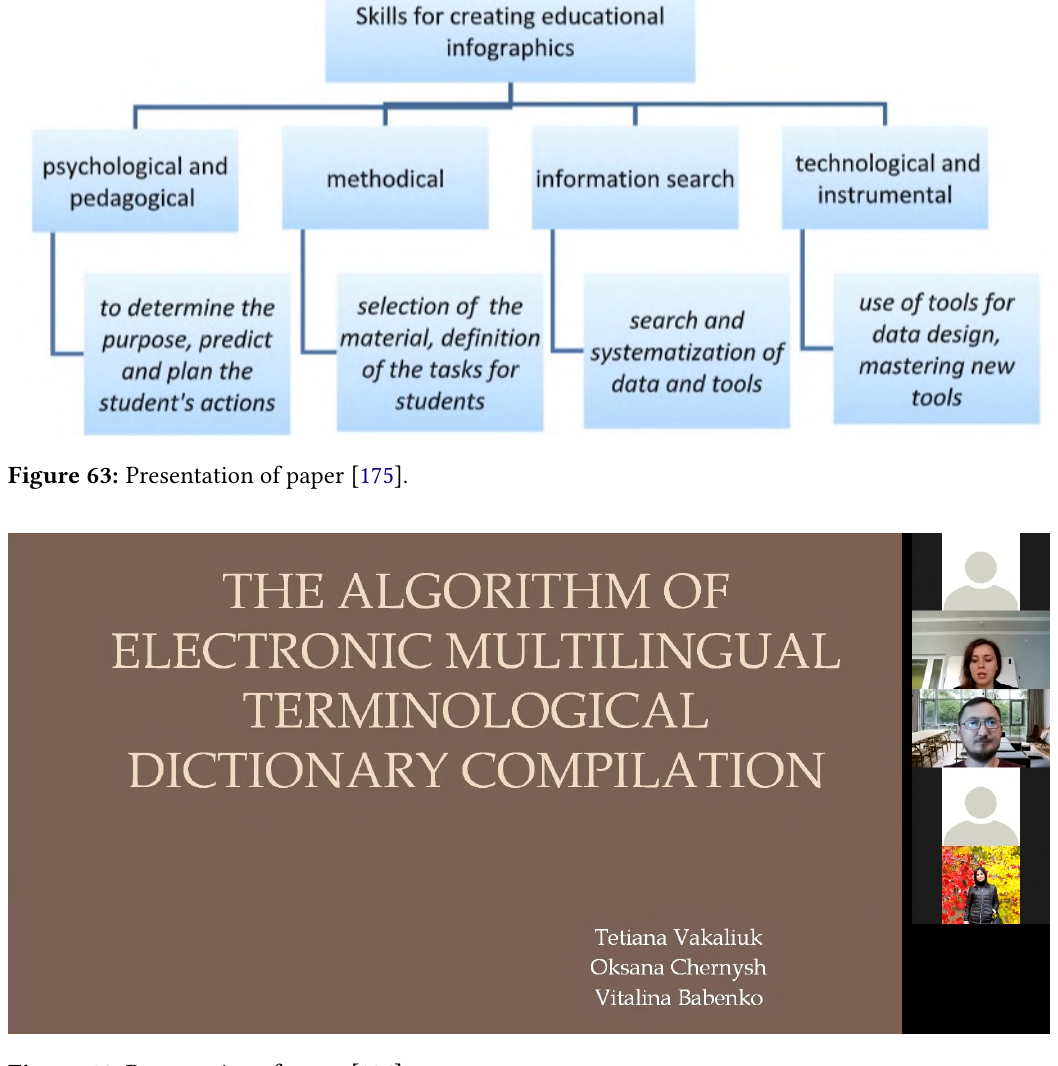
Figure 64: Presentation of paper